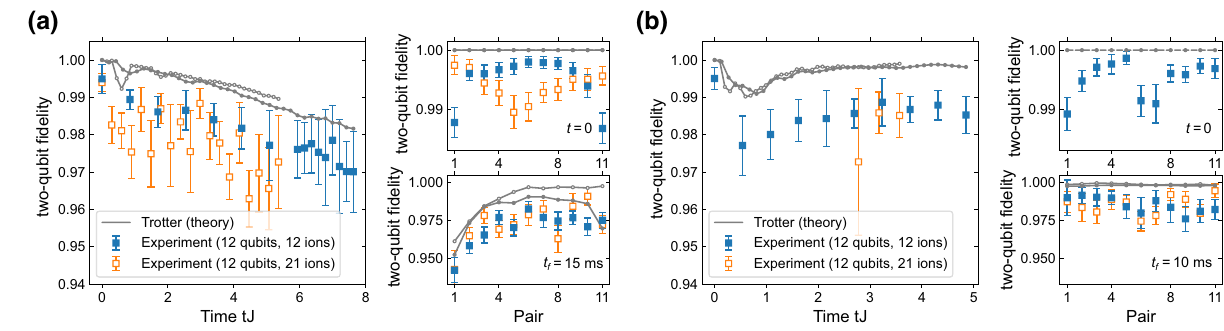
FIG. 7. The measured fidelity of the state resulting from the Trotter approximation. The fidelity of the experimentally observed state to the ideal state is averaged over ion pairs and plotted against time. The error bars indicate the standard deviation over the pairs. The smaller subplots show the fidelities, at the start and end of the evolution, to the observed states of individual ion pairs. The two types of markers represent two cases that we compare. First, we realize a 12-qubit system using a chain of only 12 ions (filled blue markers). The filled gray dots show the corresponding theoretical prediction. Second, we realize a 12-qubit system using a 21-ion chain, by hiding the extraneous ions from the interactions (empty orange markers). The open gray dots show the theoretical prediction for this case. The measurements are carried out (a) for the Trotter-approximated Heisenberg Hamiltonian and (b) for the Trotter-approximated XY Hamiltonian. The fidelity drops and revives at early times. This behavior results from the failure of the Trotter steps to conserve the charges of the exact Hamiltonian, leading to periodic